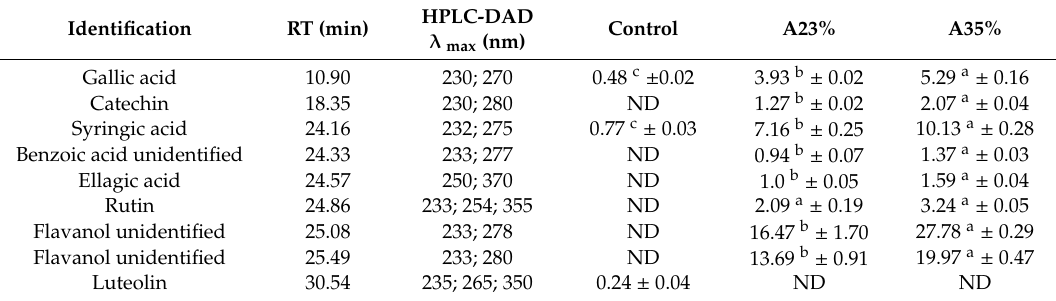
Table 6. Phenolic profile of the GFB with the incorporation of di ff erent ratios of acorn flour (A23% and A35%) and comparison with the control sample (mg g − 1 DM). HPLC-DAD: High-Performance Liquid Chromatography–Diode Array Detector.